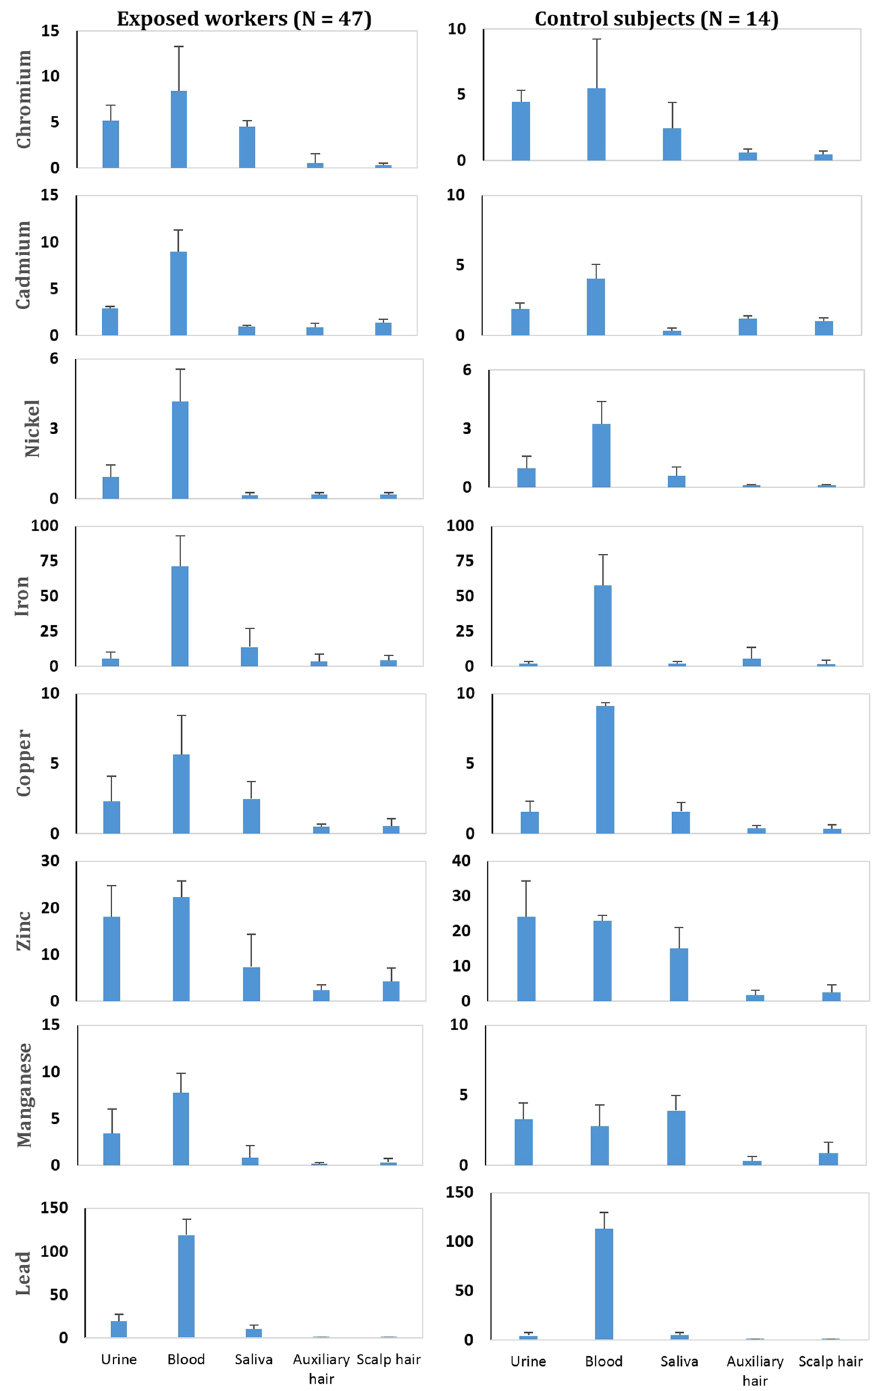
Figure 2. Heavy metal concentrations in the bio-matrices of exposed and control subjects in leather industries. Heavy metal concentrations in urine, blood, and saliva were measured in µ g/L and in µ g/g in hair